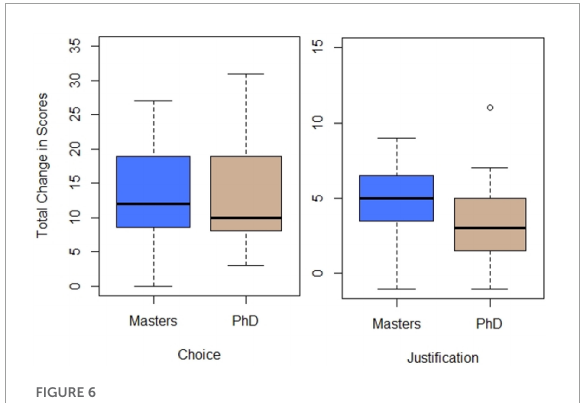
FIGURE6 Total change in scores for choice and justification of quantification technique across education